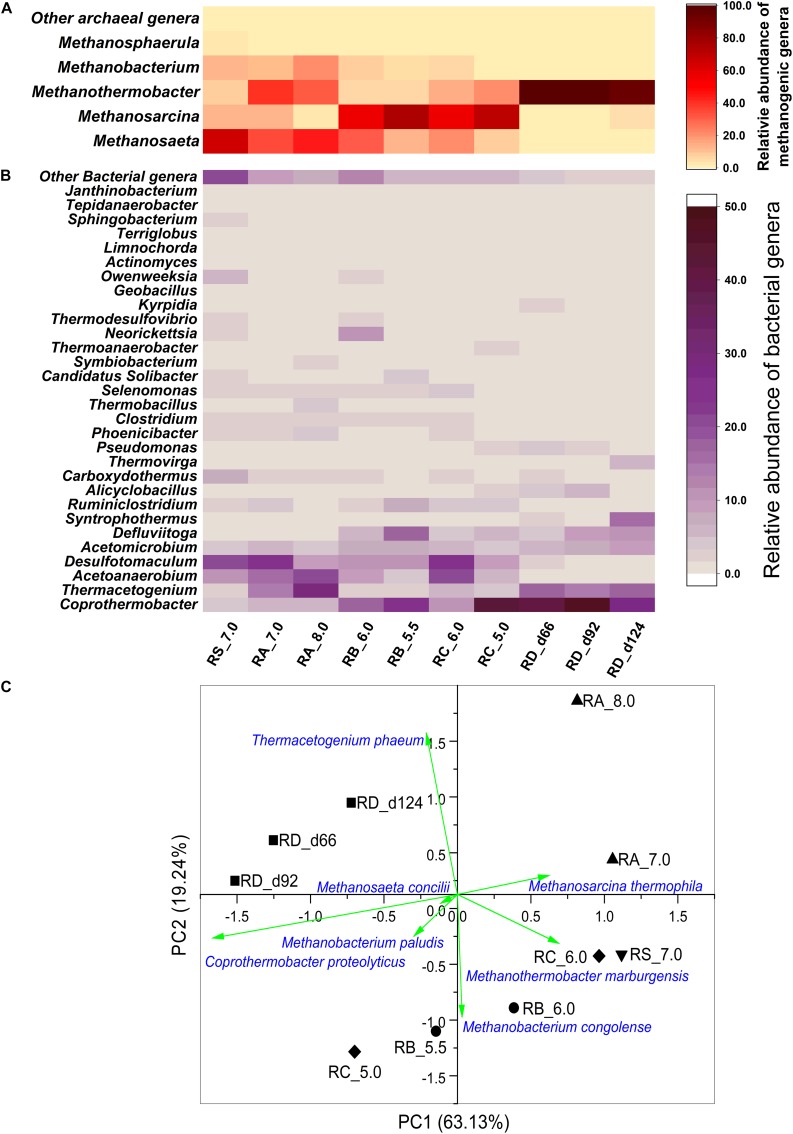
Heatmap of (A) archaeal and (B) bacterial composition of the microbial communities at the genus level in different reactors based on the 16S rRNA data. Only genera with relative percentage higher than 1% are shown. The genera with relative percentage lower than 1% were aggregated as Other archaeal genera and Other bacterial genera. (C) Principal component analysis (PCA) based on the relative abundance of microbial species. (▼) Reactor RS_7.0, (▲) Reactor RA_7.0-8.0, (●) Reactor RB_6.0-5.5-5.0, (◆) Reactor RC_6.0-5.0, (■) Reactor RD_5.5.